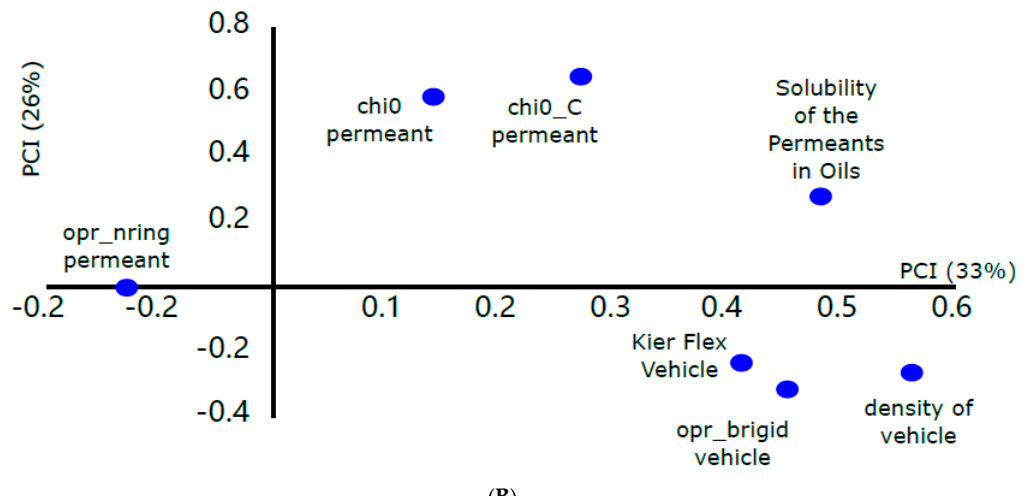
Figure 4. ( A ) Score plot from PCA showing the relationship between permeant and oily vehicle descriptors with epidermis flux. The two displayed PCs explain 33% and 26% of the variance, respectively. ( B ) Loading plots from PCA showing the relationship between permeant-oily vehicle descriptors with epidermis flux.